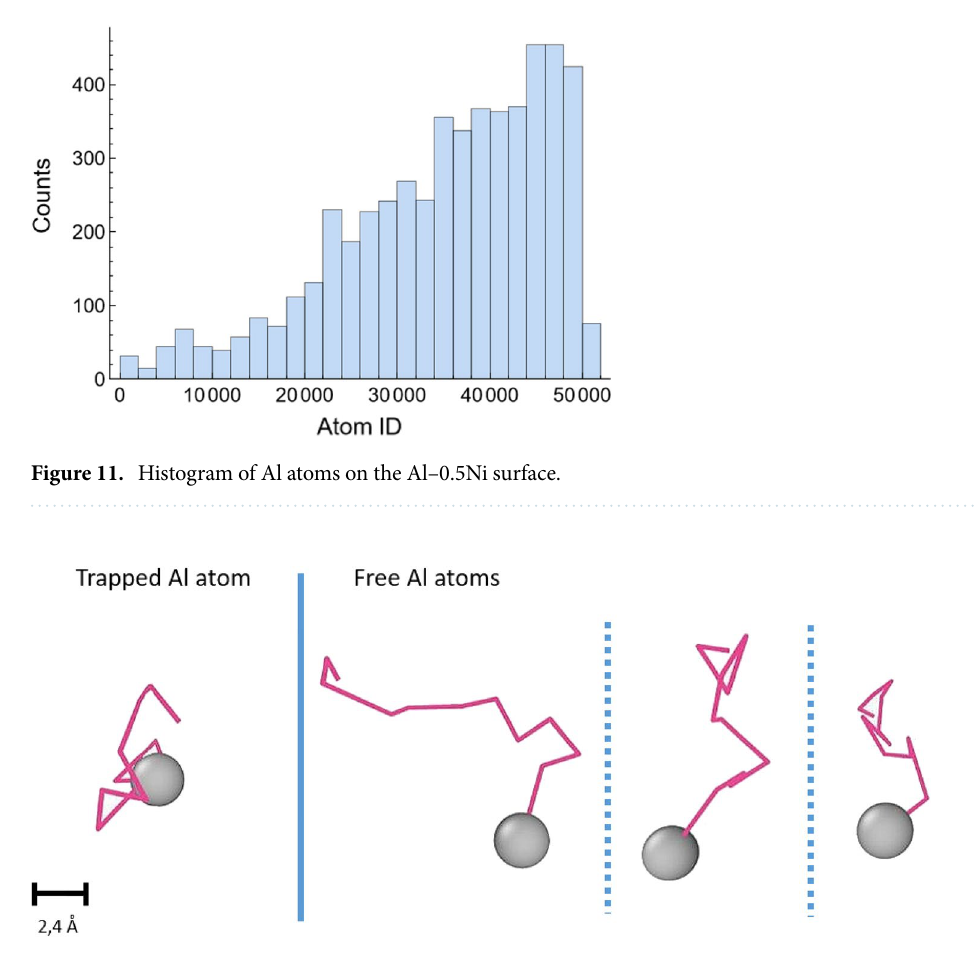
Figure 12. Trajectory of trapped and free Al atoms in Al–0.5Ni